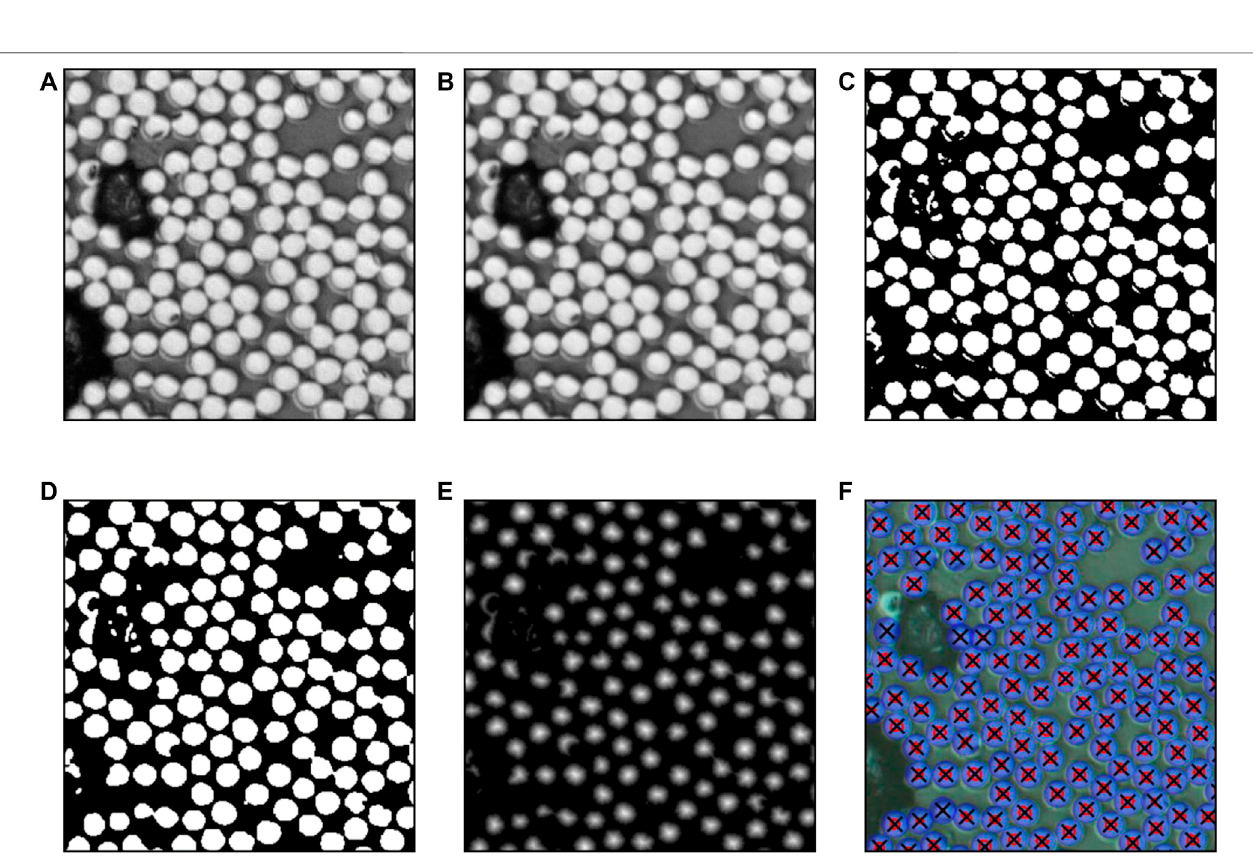
FIGURE 2 | Sequence of image analysis steps to fi nd the fi ber fi lament center positions in micrograph images. The original gray scale image is shown in (A) and minimalnoiseis fi lteredbyblurring (B) .AGaussianadaptivethresholdgivesablackandwhitecontrast (C) .Smallartefactsareremovedbyanopeningtransformation (D) and a Laplacian distance transform is obtained in (E) . A normal thresholding of this distance transform yields the red contours in (F) superimposed on the original image with the center positions in black and blue semitransparent circles of radius 7 µm.